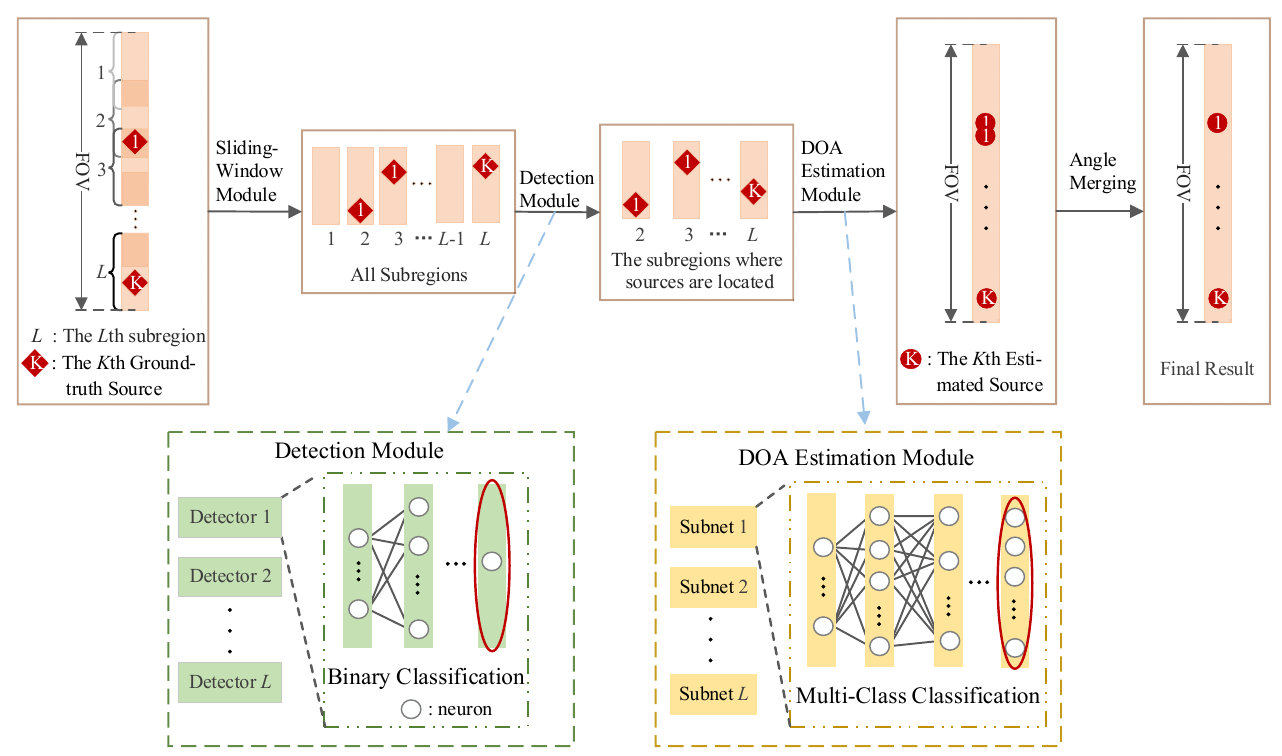
Figure 2. The architecture of DNN-SW for DOA estimation.